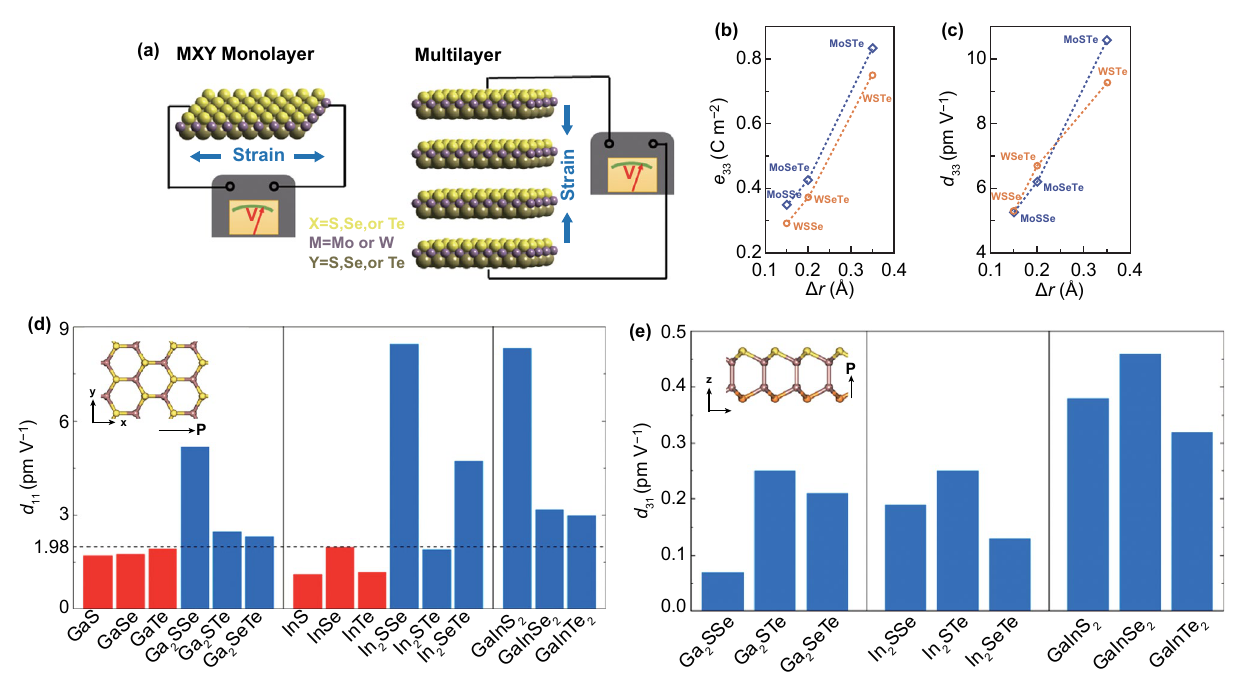
Fig. 4 Simulation studies of out-of-plane piezoelectric effect in 2D semiconductors. a Schematic diagram of in-plane and out-of-plane piezo- electric potential generation in Janus monolayer TMDs. The out-of-plane piezoelectric coefficient b e 33 and c d 33 of multilayer Janus monolayer TMDs. Reproduced with permission [95]. Copyright 2017, American Chemical Society. The piezoelectric coefficients d d 11 and e d 31 of Janus group III chalcogenide monolayers; the inset is top view and side view of Janus structures M 2 XX’. Reproduced with permission [97].